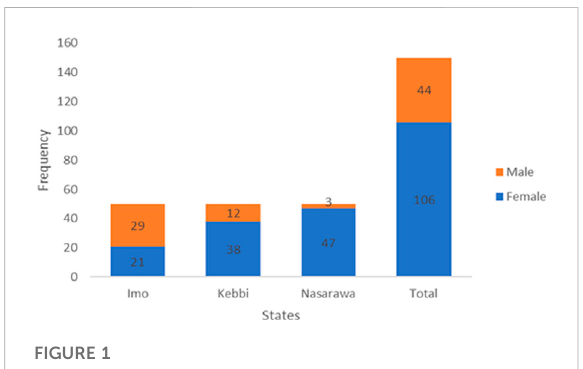
FIGURE 1 Gender distribution of smallholder poultry farmers in the